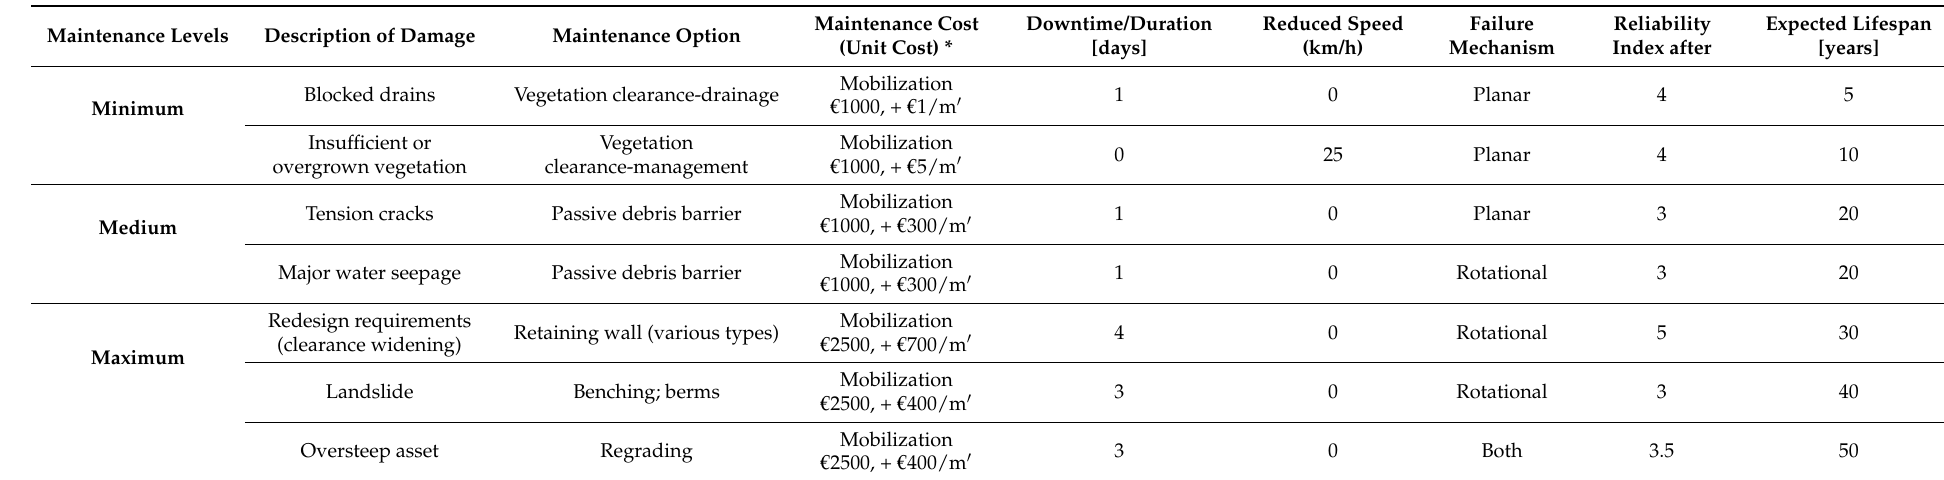
Table 1. Intervention rules for earth slopes (cuttings and embankments).